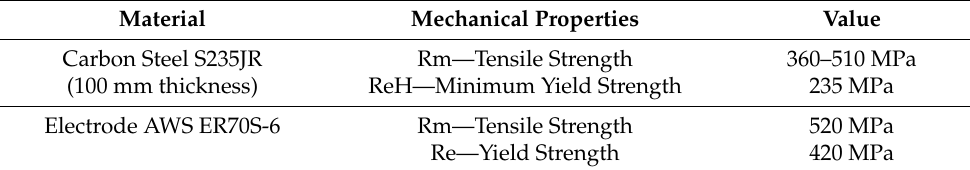
Table 1. Mechanical properties for the base metal and electrode.